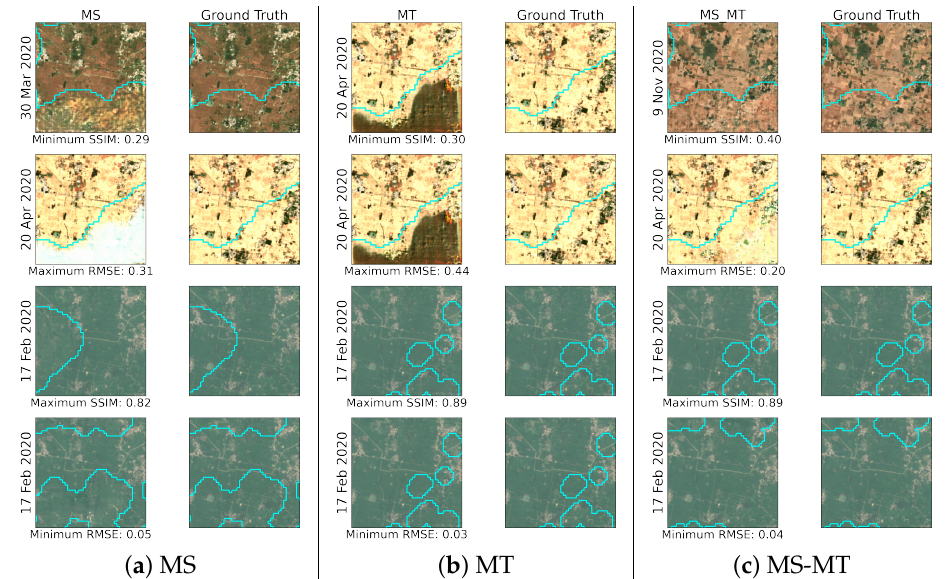
Figure 10. Reconstructions with the lowest ( top two rows ) and highest ( bottom two rows ) perfor- mance for both SSIM and RMSE for the India region. Each row contains all three stacked modes (MS, MT, and